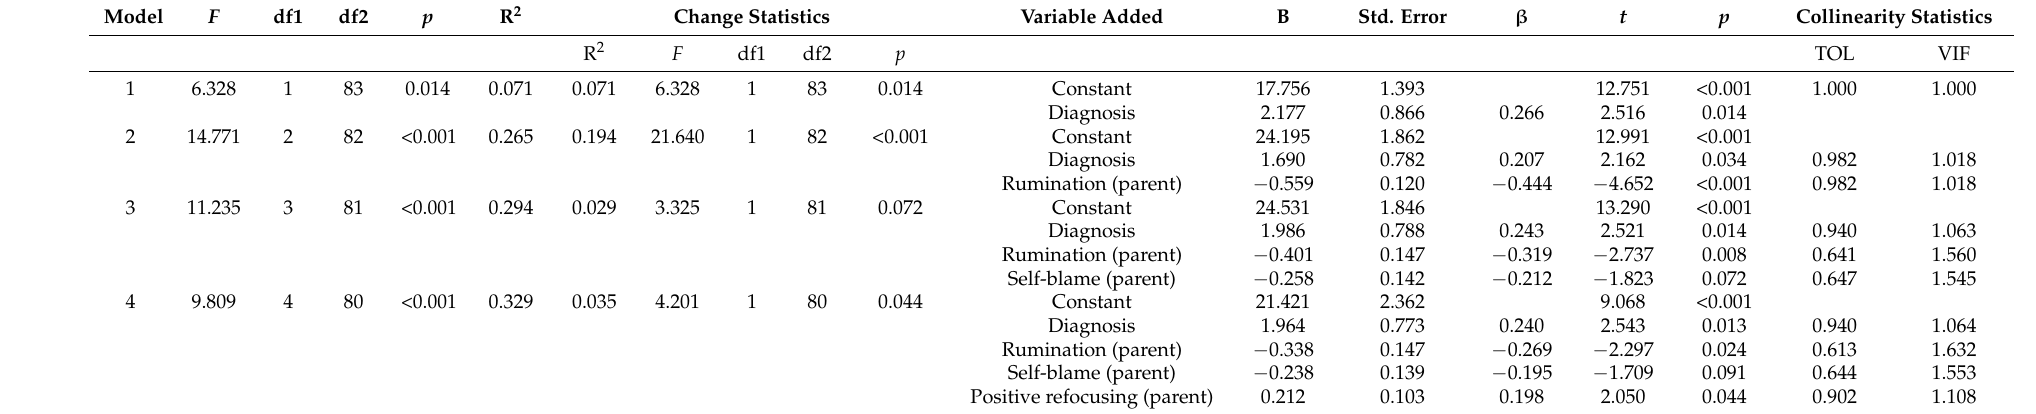
Table 5. Hierarchical Linear Regression Analysis with ILC proxy as Dependent